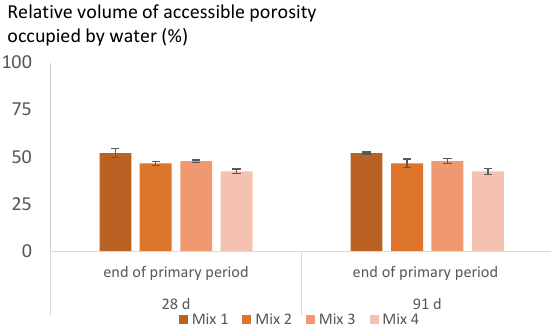
Figure 7. Relative volume of occupied porosity by the water in the sample at the end of the primary imbibition period in Mixes 1 ‐ 4 cured for 28 and 91